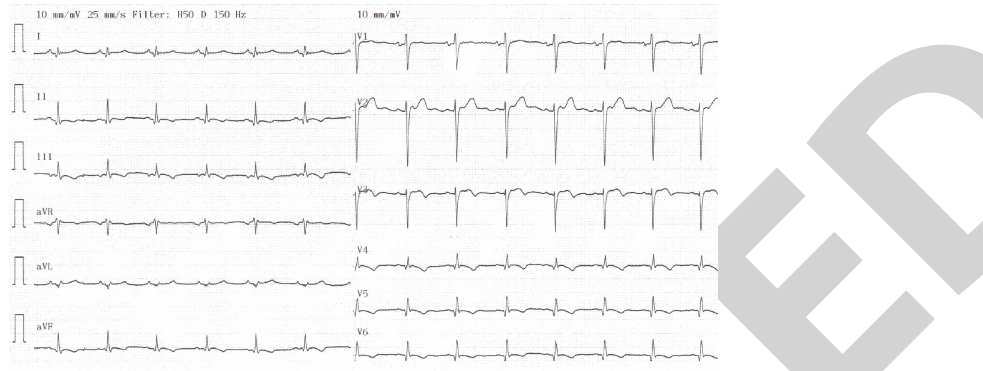
Figure 1: 12-lead electrocardiogram obtained on day five of the index admission. Abnormal Q-waves are seen in the left sided leads I, aVL, and V4–V6. The QTc interval was normal at 395 msec (Fredericia correction).